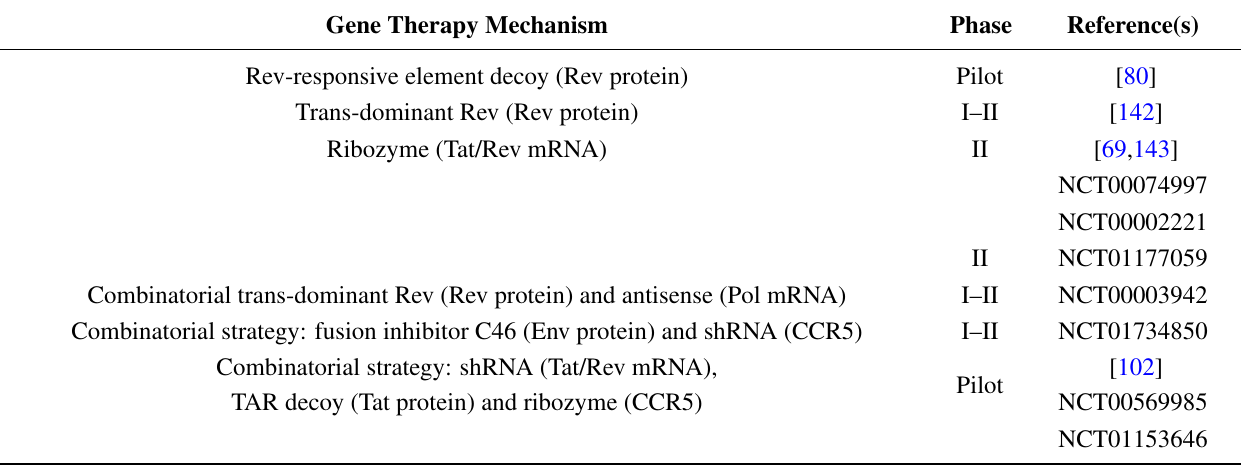
Table 1. Clinical trial of HIV gene therapy based on modified HSC